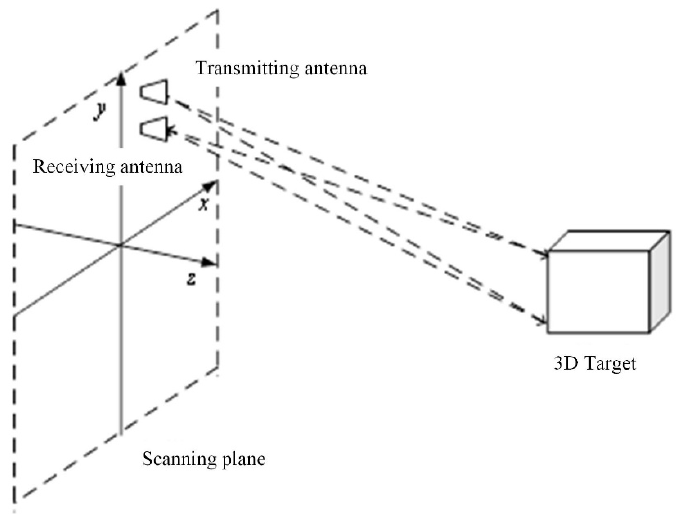
Figure 3. The schematic of the measurement setup in the simulation process.